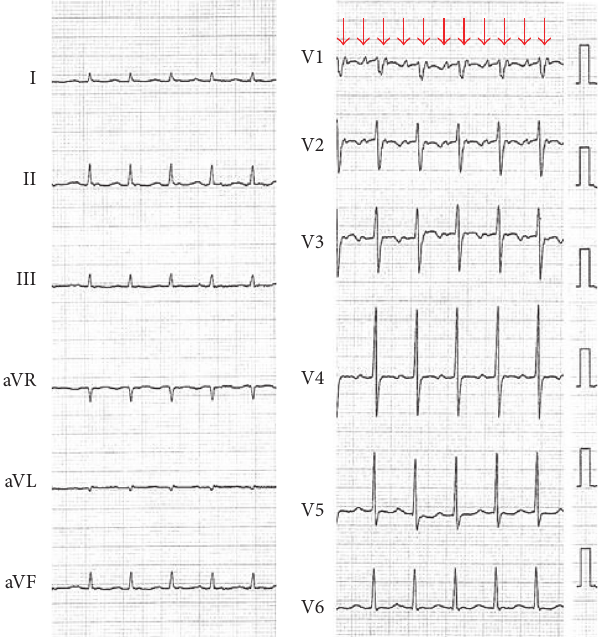
Figure 1: Electrocardiogram revealed atrial tachycardia (AT) with 2: 1 atrioventricular conduction. P wave (red arrow) morphology was positive in inferior leads (II, III, and aVF), positive in lead V1, and isoelectric in aVL.